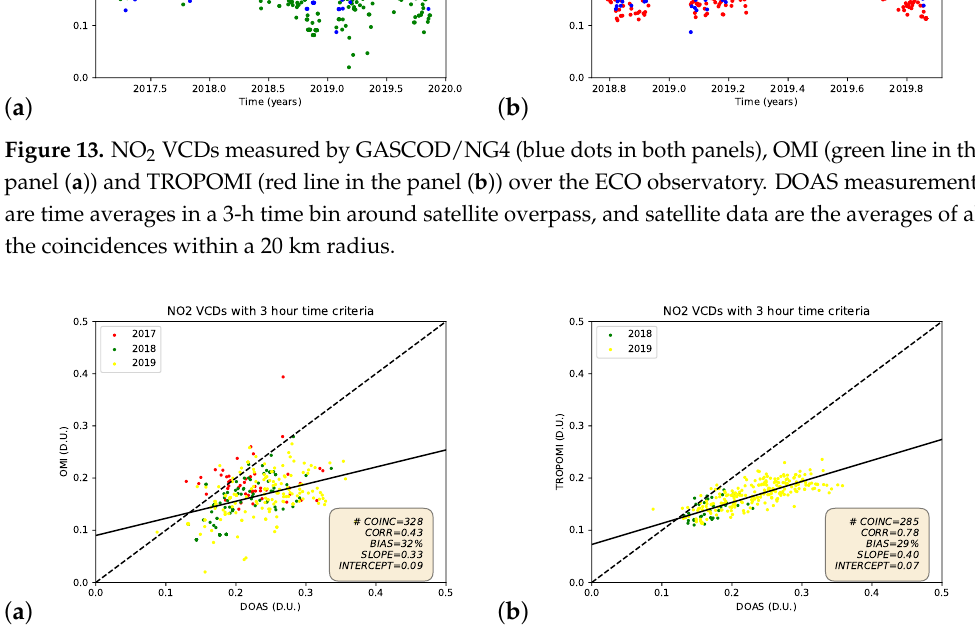
Figure 14. Scatterplot of NO 2 VCDs measured by GASCOD/NG4 versus OMI ( a ) and TROPOMI ( b ). DOAS data were averaged in a 3-h time bin around satellite overpass and are compared with the mean satellite VCDs in the same time bin and within a radius of 20 km from the ECO